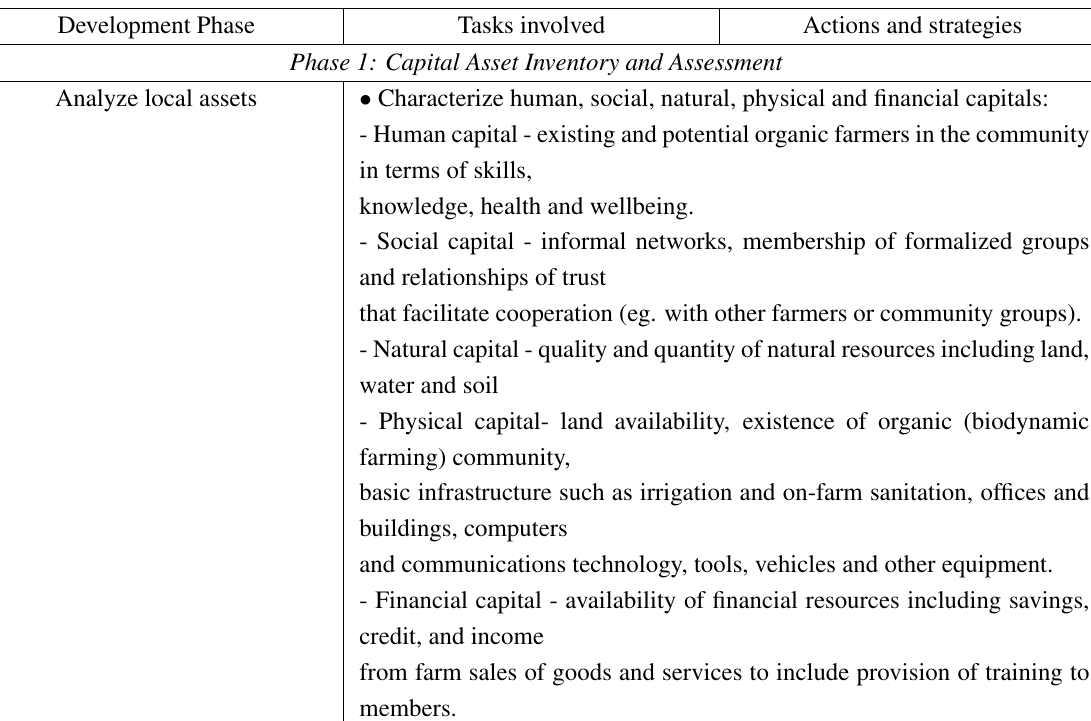
Table 1. Phasesof development planning for CSA as a smallholder organic farming enterprise development